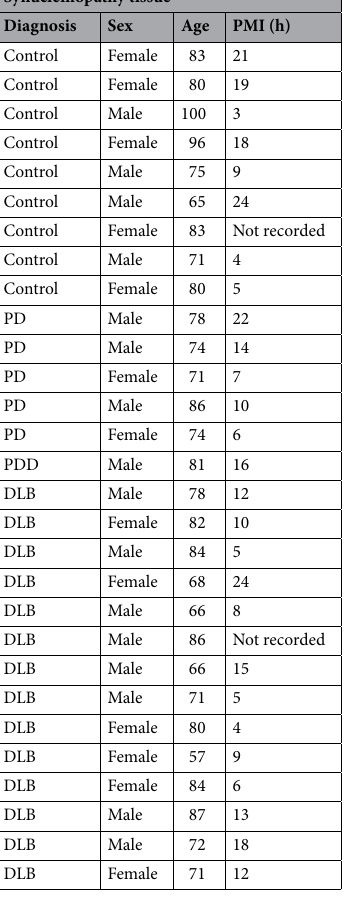
Table 1. Synucleinopathy samples used for analysis of